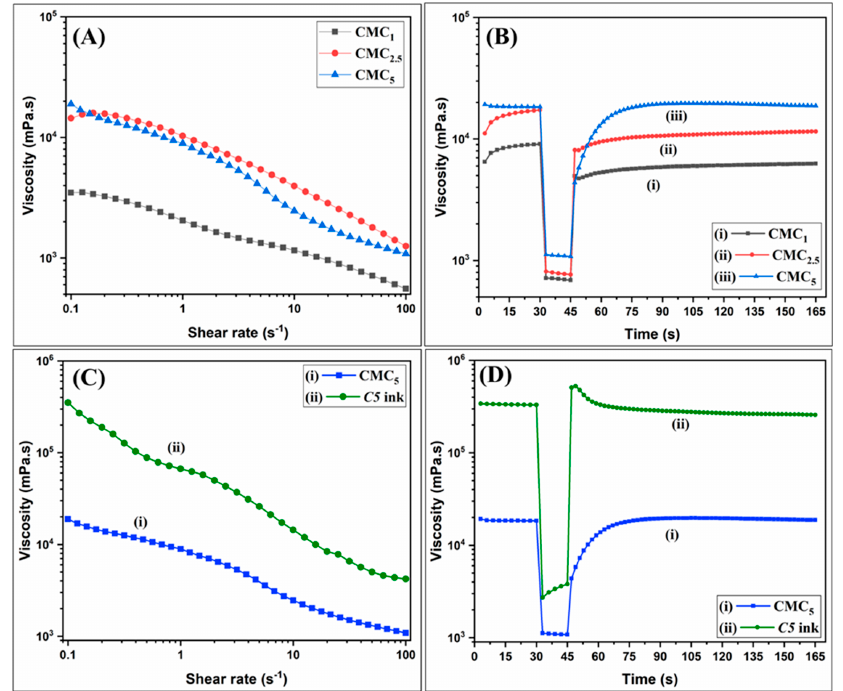
Figure 1. ( A ) Viscosity flow curves showing the change in viscosity of the CMC 1 , CMC 2.5 , and CMC 5 base emulsions with shear rate in the range of 0.1–100 s − 1 , ( B ) Change in viscosity of the CMC 1 , CMC 2.5, and CMC 5 base emulsions with time when subject to sudden change in the shear rate, ( C ) Viscosity fl ow curves of the CMC 5 base emulsion and the C5 ink with shear rate in the range of 0.1–100 s − 1 , and ( D ) Change in viscosity of the CMC 5 base emulsion and C5 ink with time when subject to sudden change in shear rate. The C5 ink was prepared by dispersing cMWCNT into the CMC 5 emulsion base uni- formly, and the e ff ect of cMWCNT on the fl ow properties of the fi nal ink was observed (Figures 1C,D). As shown in Figure 1C, the initial viscosity of the C5 ink at 0.1 s − 1 was found to be signi fi cantly higher (352.1 Pa.s) than the CMC 5 emulsion. However, the ink retained its shear thinning property as the viscosity decreased linearly with the shear rate. It is also interesting to note that, during the thixotropy test (3iTT), the initial viscosity of the C5 ink (329.8 Pa. s at 0.1 s − 1 at 30 s) decreased by ~100 times to 3.79 Pa.s (~1% of the initial viscosity) at 200 s − 1 at 45 s. The viscosity further recovered to 90% of its initial value at 75 s after the removal of the stress. This indicated that the addition of cMWCNTs did not a ff ect the thixotropic behavior of the ink and hence the C5 ink can potentially be used in screen printing of high-resolution pa tt erns. Similar rheological behavior has been ob- served in other studies wherein MWCNT and other nanomaterials, such as silver, gra- phene, etc., were used as conductive fi llers [29,31,32]. It has been reported that the pres- ence of carbon nanomaterials as fi llers in an ink increases the structural strength of the ink, and hence it may lead to a faster recovery of the viscosity [32]. The high viscosity recovery suggests that the colloidal stability of the ink is maintained even at higher shear